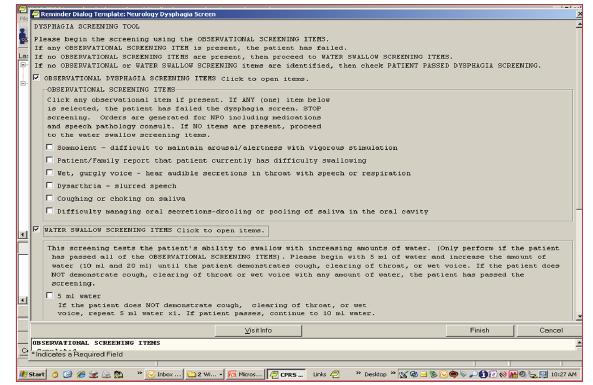
Figure 2: Template of swallowing screening in the electronic health record